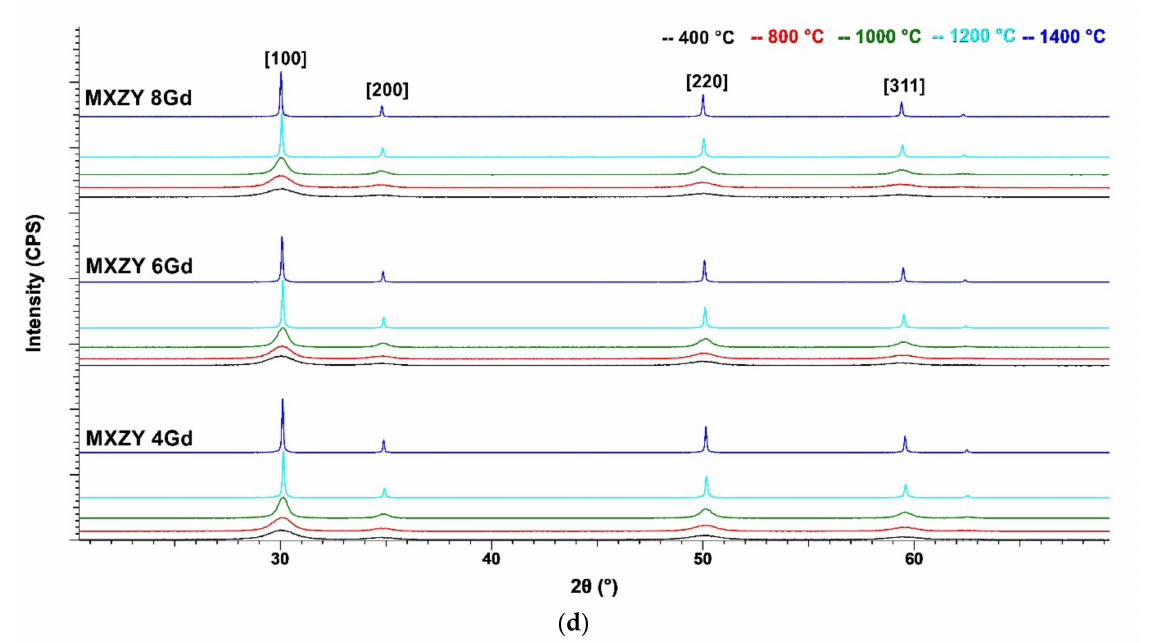
Figure 3. ( a ) XRD spectra of 8 wt.% YSZ powders co-doped with 4, 6 and 8 wt.% La 2 O 3 thermal treated at different temperatures; ( b ) XRD spectra of 8 wt.% YSZ powders co-doped with 4, 6 and 8 wt.% Nd 2 O 3 thermal treated at dif- ferent temperatures; ( c ) XRD spectra of 8 wt.% YSZ powders co-doped with 4, 6 and 8 wt.% Sm 2 O 3 thermal treated at different temperatures; ( d ) XRD spectra of 8 wt.% YSZ powders co-doped with 4, 6 and 8 wt.% Gd 2 O 3 thermal treated at different temperatures.